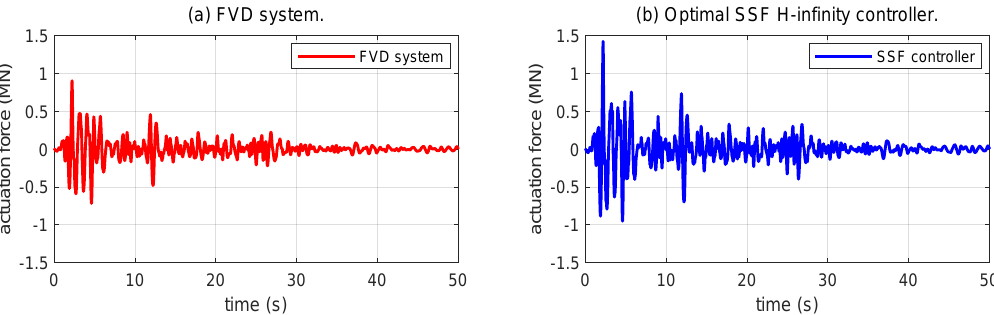
Figure 9. Actuation-force time-history u 3 ( t ) for the FVD system and the optimal SSF H ∞ controller.